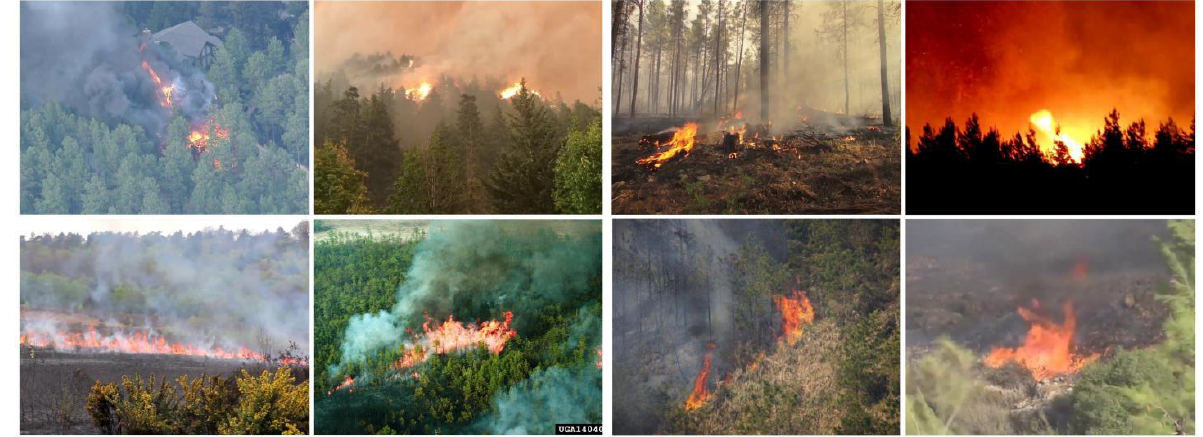
Figure 1. Schematic diagram of forest fire data set.